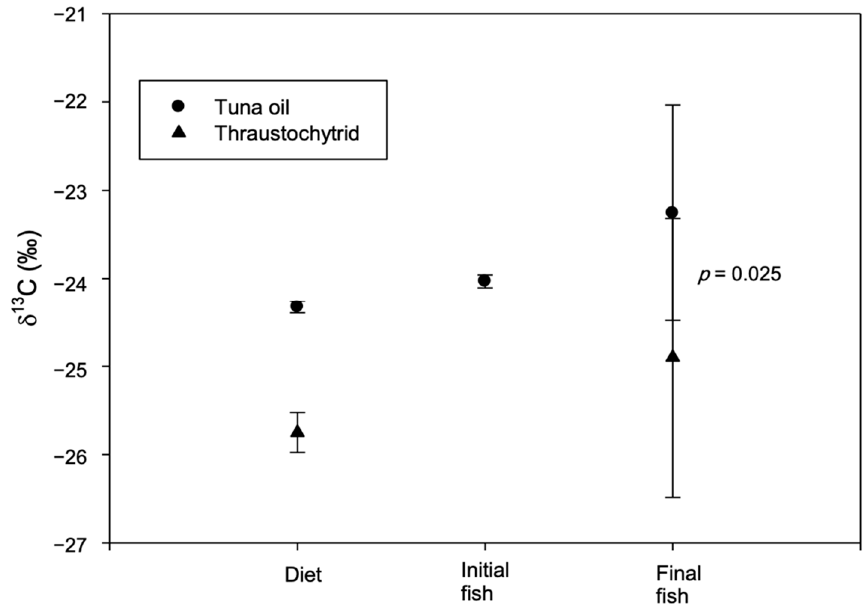
Figure 4. Stable isotope ratios of 22:6 ω 3 in the diets, the initial fingerlings and the salmon whole carcass at the end of the 70 day feeding period.